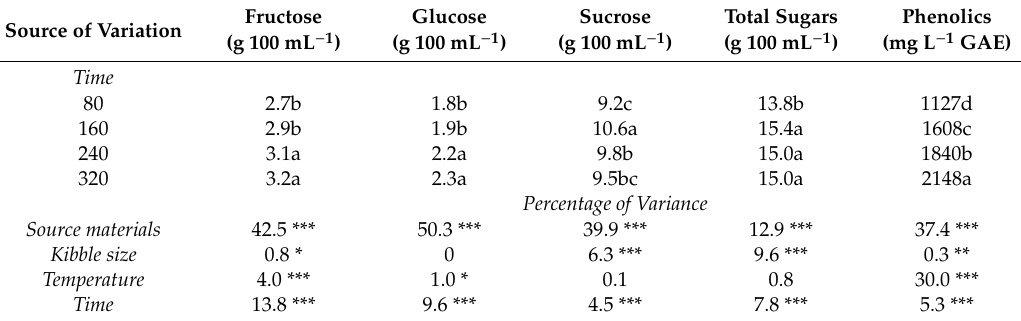
Figure 2. Interaction plots for total phenolics and sugars obtained by ultrasound-assisted extraction (UAE; ( A , B )) of different source materials (LF: Lefkaritiki; MV: Mavroteratsia) and kibble sizes (medium and powder). UAE extraction varied in extraction time (30 and 60 min). Data points represent means of three replicates with standard error bars. Comparing the two extraction methodologies under similar temperature–time conditions by t- Test analysis, the HAE at 50 °C for 80 min (14.4 g 100 mL − 1 ; 1150.3 mg L − 1 GAE) demonstrated significantly higher total sugars and phenolics yield (P-sugars < 0.001, P-phenolics < 0.01) compared to UAE at 40 °C for 60 min (12.1 g 100 mL − 1 ; 943.2 mg L − 1 GAE). The lower phenolics concentration in the juice facilitated by UAE was therefore outweighed by the lower sugar yield obtained.